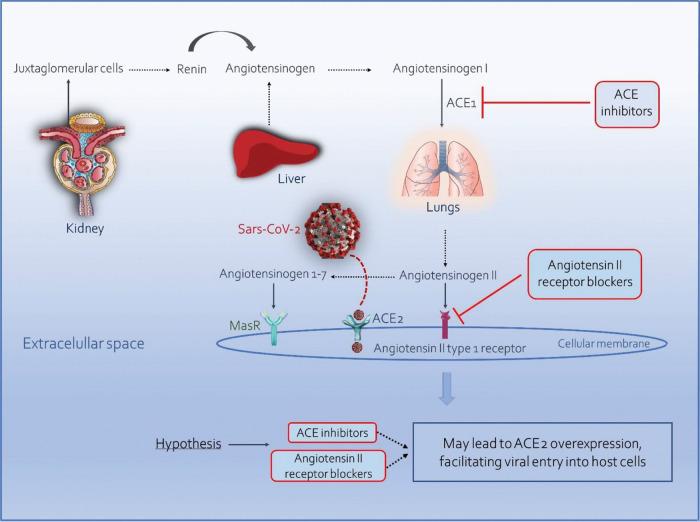
Renin-angiotensin-aldosterone system and drugs that act on this system. MasR: Mas receptor; ACE1: ACE2: Angiotensin-converting enzyme 2.